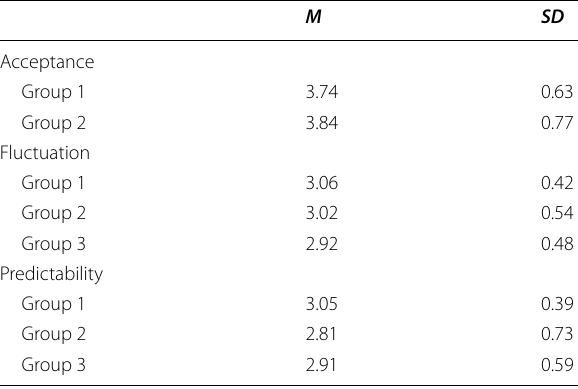
Table 2 Descriptive statistics for dependent